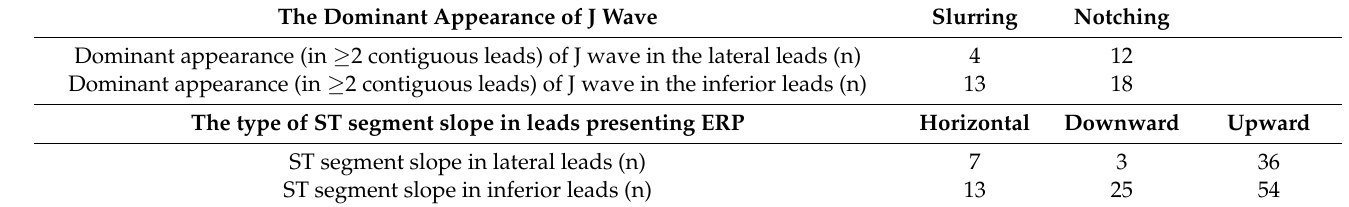
Table 1. The main characteristics of the ERP pattern in the study population.